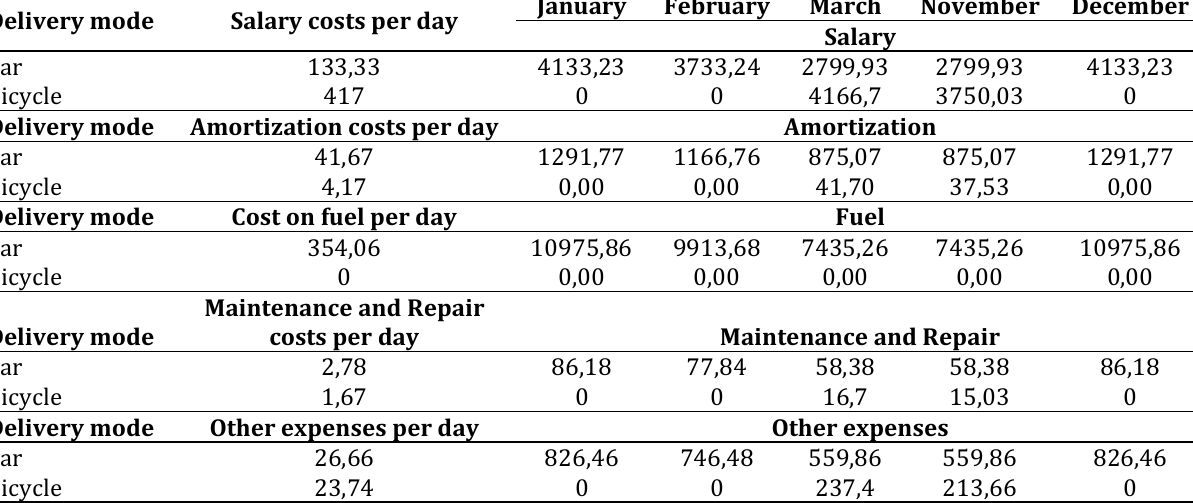
Table 7: Internal costs of combination “Car+Bicycle” for season with difficult weather conditions Delivery mode